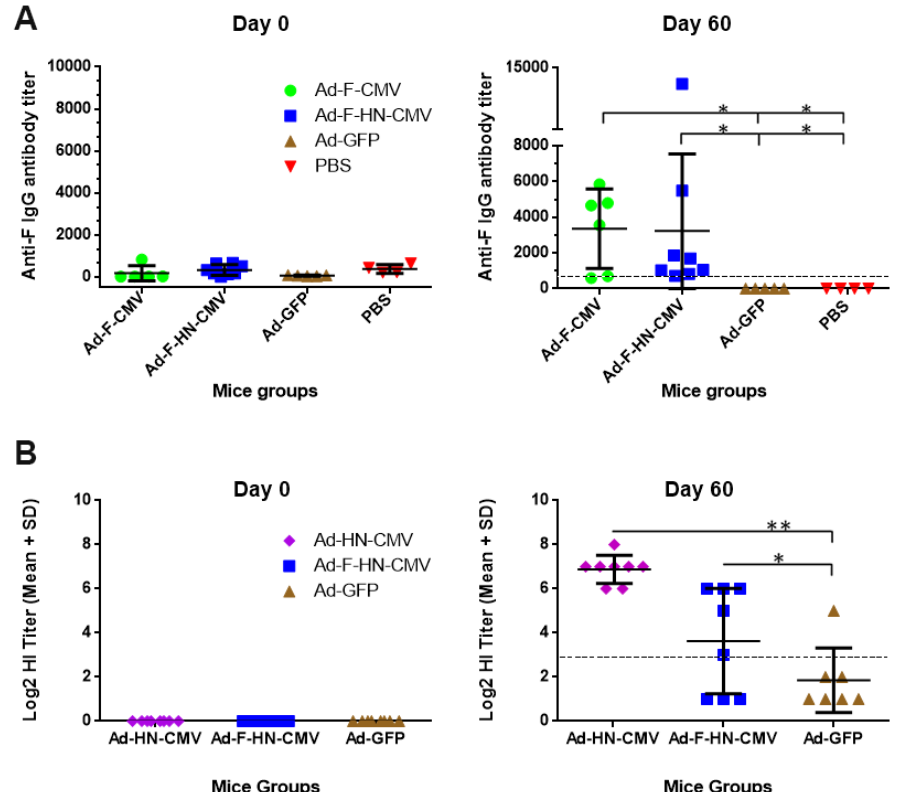
Figure 6. Analysis of the humoral immune response generated in mice against NDV after vaccination with the recombinant adenoviral vectors Ad-F-CMV, Ad-HN-CMV, Ad-F-HN-CMV, and Ad-GFP-CMV (negative control): Enzyme-Linked Immunosorbent Assays (ELISA) and Hemagglutination Inhibition Assay (HIA) assays were conducted for the detection of anti-F IgG antibodies and antibodies with HI activity, respectively, in the serum of vaccinated mice. Mice were immunized via i.m. injections at days 0 and 21 with doses of 10 7 TCID 50 . ( A ) The mean ± standard deviations of anti-F IgG antibody titers measured at days 0 and 60 of the experiment. Specific titers elicited by the Ad-F-CMV and the Ad-F-HN-CMV vectors increased over the indicated cuto ff ( > 993) for existence of protective immunity (dotted line). Both groups of animals, injected with the Ad-F-CMV or Ad-F-HN-CMV viruses, showed statistically significant di ff erences compared to the negative controls. ( B ) The generation of antibodies with hemagglutination inhibition capacity in vitro is shown. Mean titers were calculated from values of antibodies with HI activity detected in serum of animals using the logarithm base 2 of the titer. In animals vaccinated with the Ad-HN-CMV and Ad-F-HN-CMV, this response was statistically superior to measurements in the negative control group. According to the routine practices at the NVI, di ff erent degrees of protection against NDV are achieved in chickens when HI titers over Log 2 (3) (dotted line). Statistically significant di ff erences ( p < 0.05) are represented with one asterisk in the figure and two for p < 0.01.